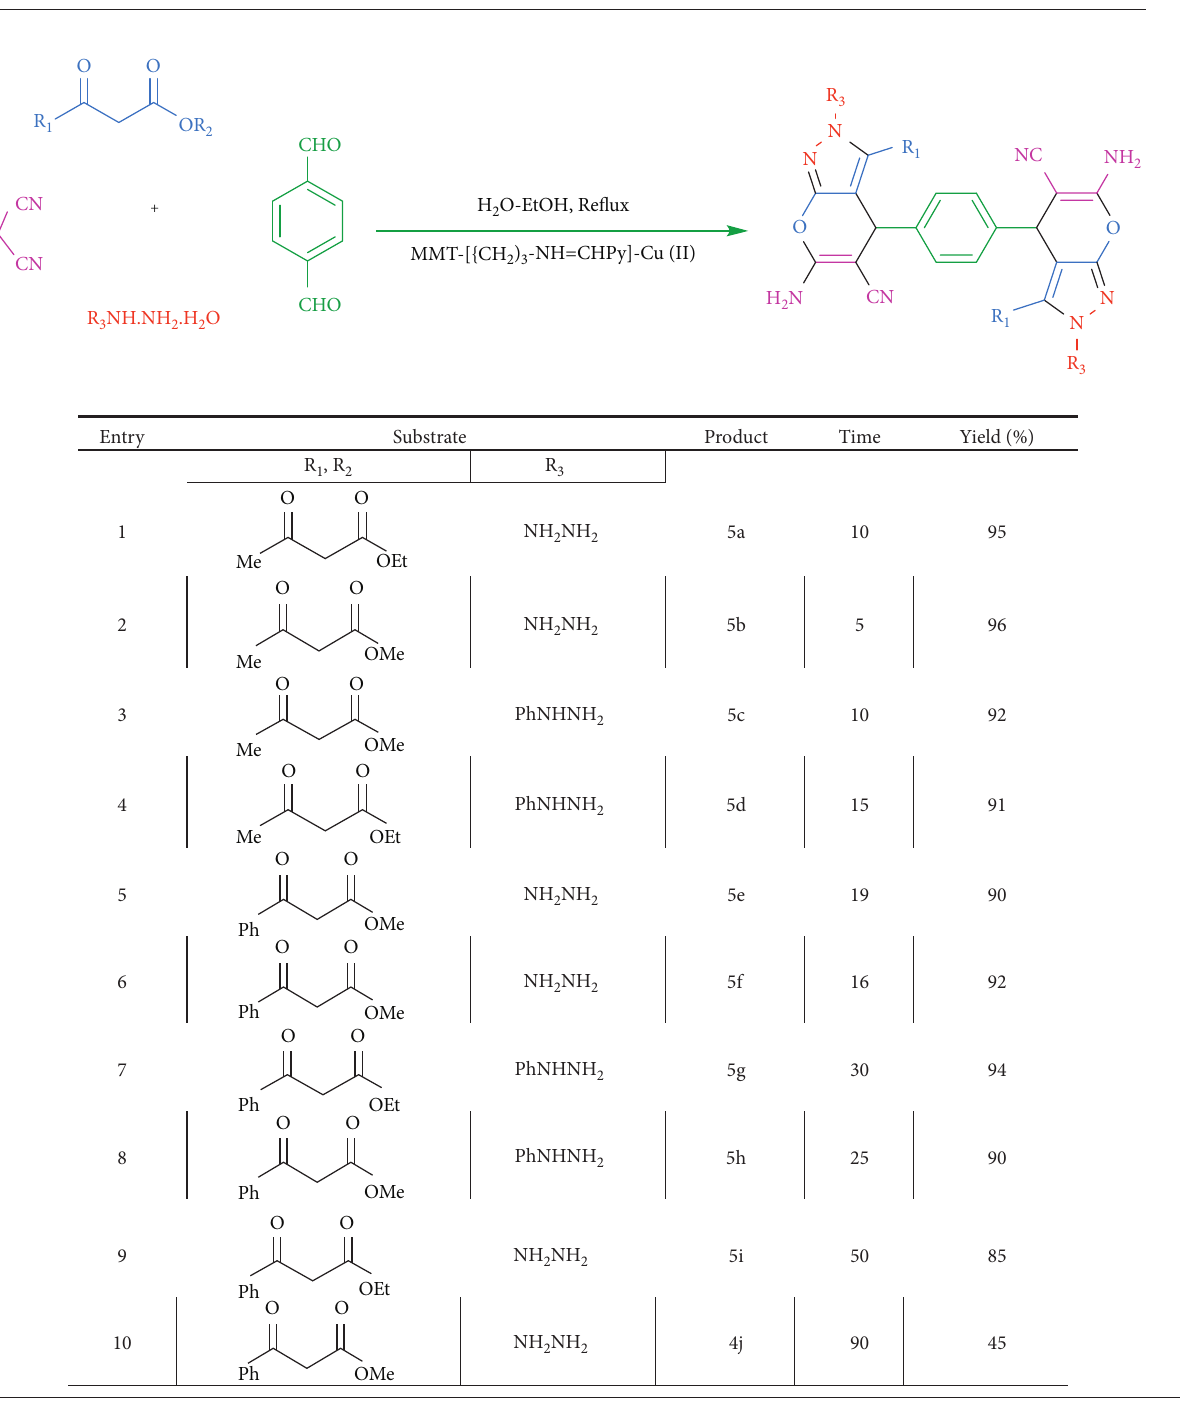
Table 3: Using MMT-[(CH � CHPy]-Cu(II) in preparation of various of bispyrano[2,3-c]pyrazole 2 ) 3 -NH